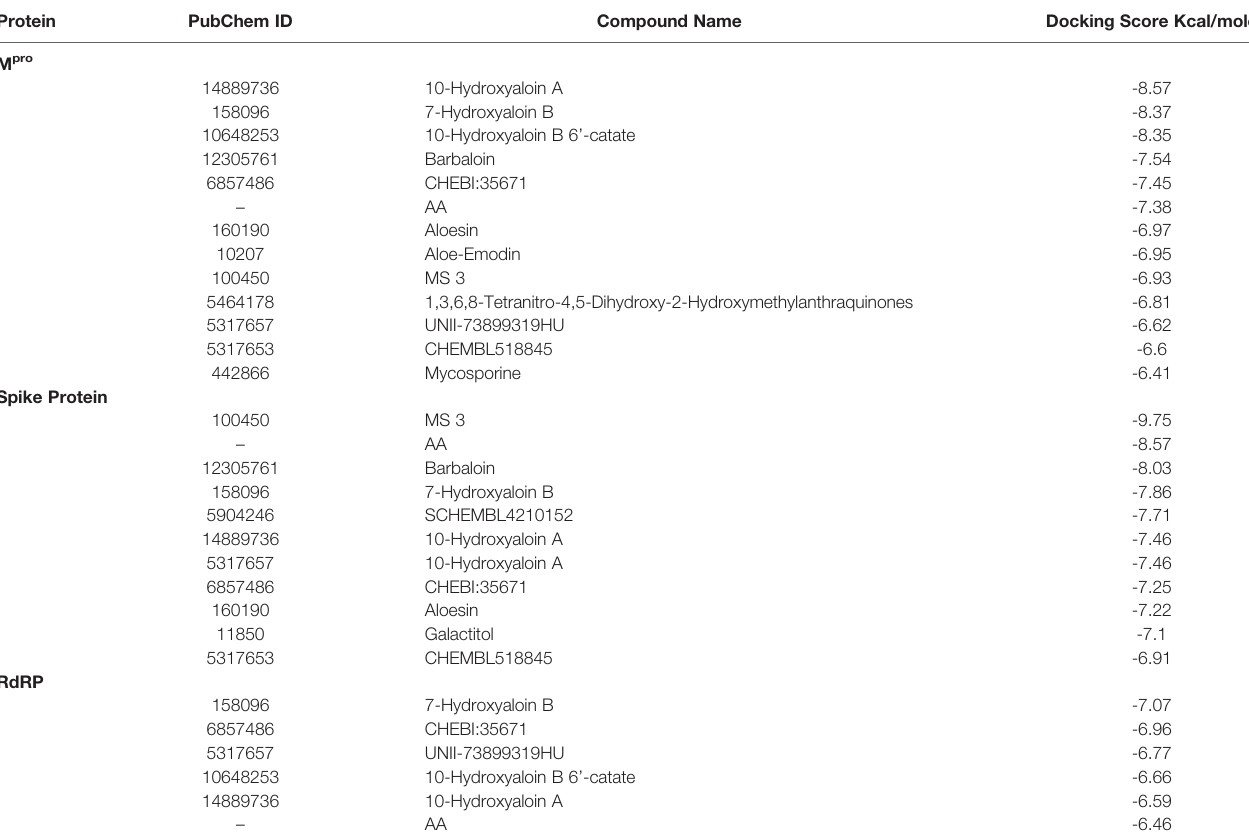
TABLE 1 | Docking score of Aloe vera phytochemicals against drugable targets of SARS-CoV-2 virus. Protein